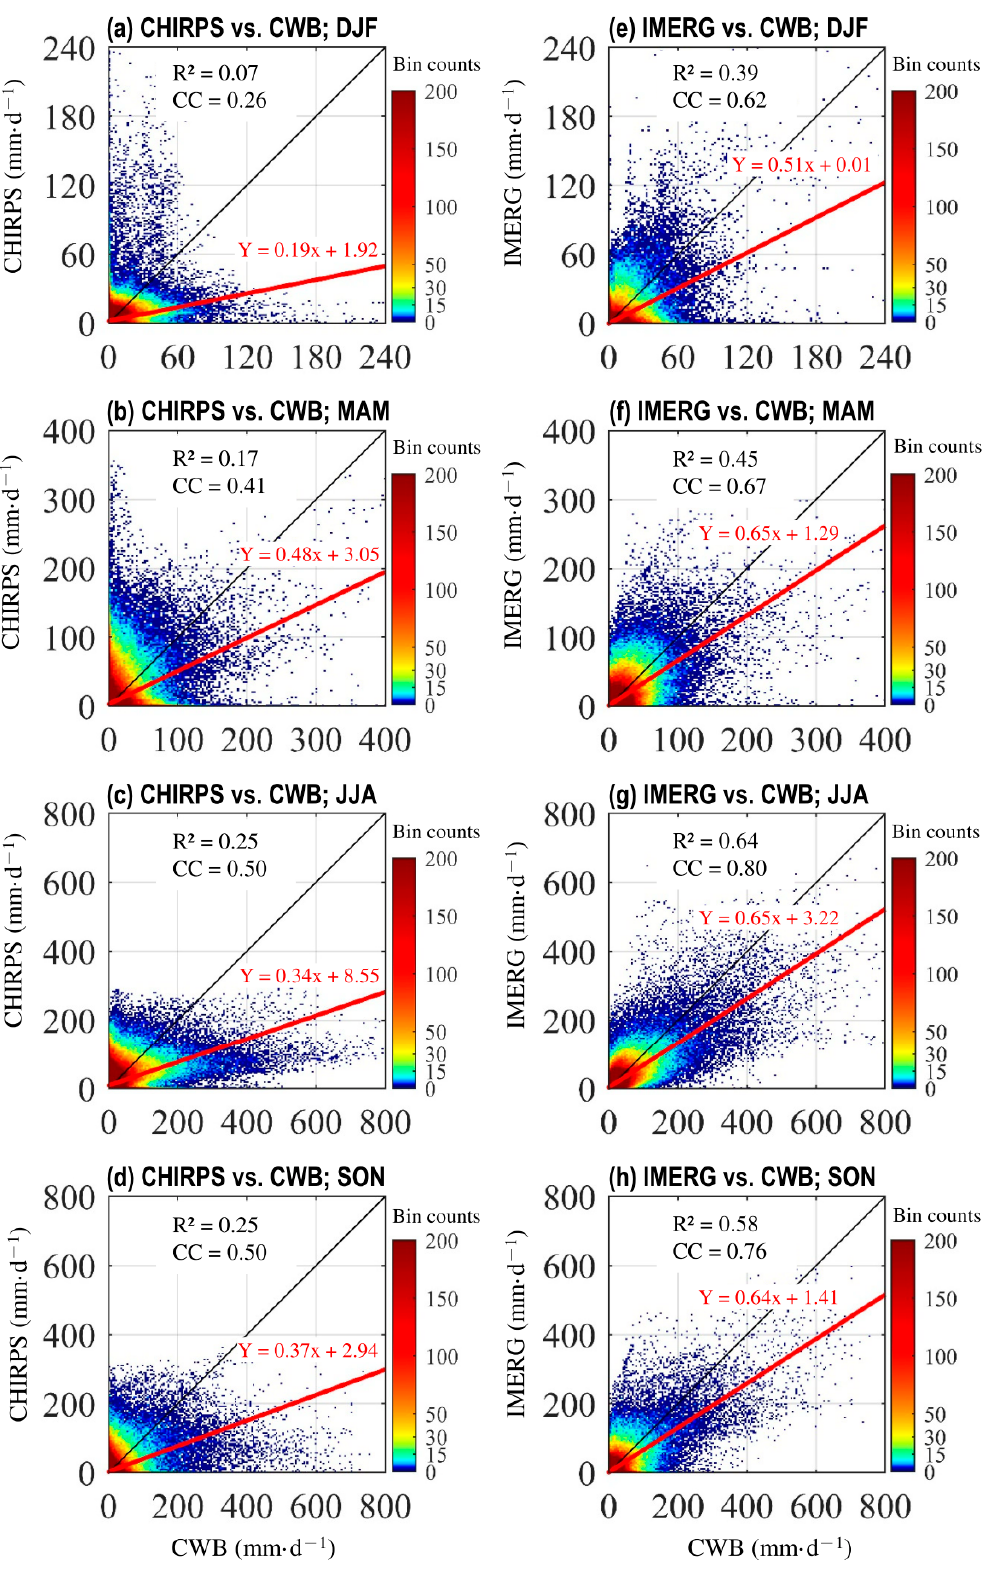
Figure 8. Scatter plot between CWB ( x -axis) and CHIRPS ( y -axis) for all grids of daily precipitation for ( a ) winter, ( b ) spring, ( c ) summer, and ( d ) autumn during 2001–2019. ( e – h ) is similar to ( a – d ), respectively, but shows the comparison between CWB ( x -axis) and IMERG ( y -axis).